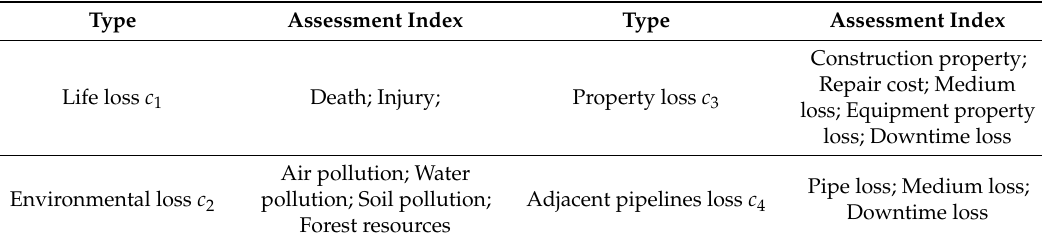
Table 1. Factors considered in monetary